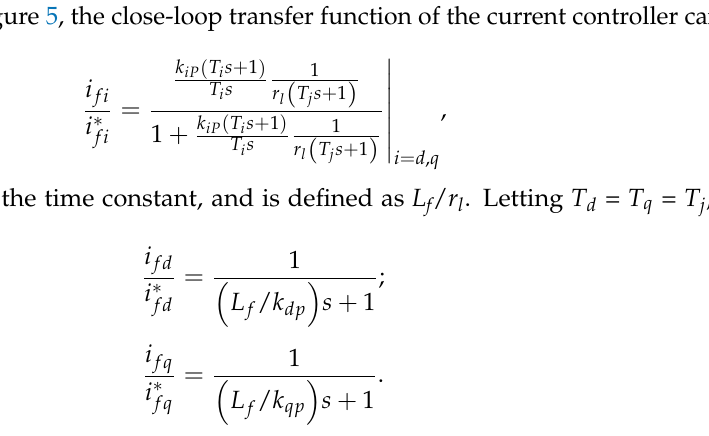
Figure 5. Schematic architecture of the current controller.